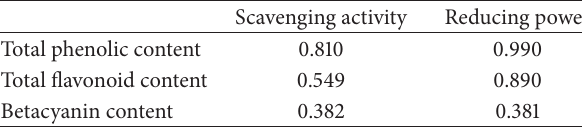
Table 2: Correlation of the phytochemical contents with different antioxidant